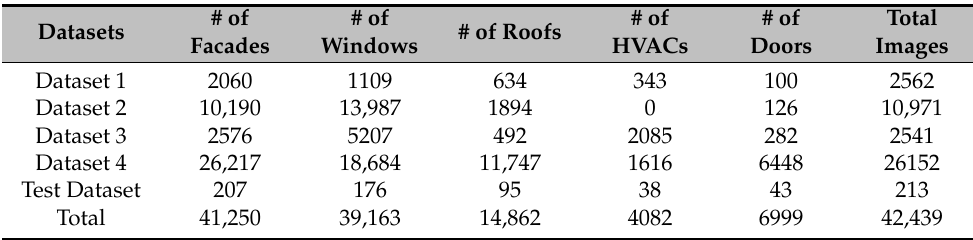
Table 3. Dataset